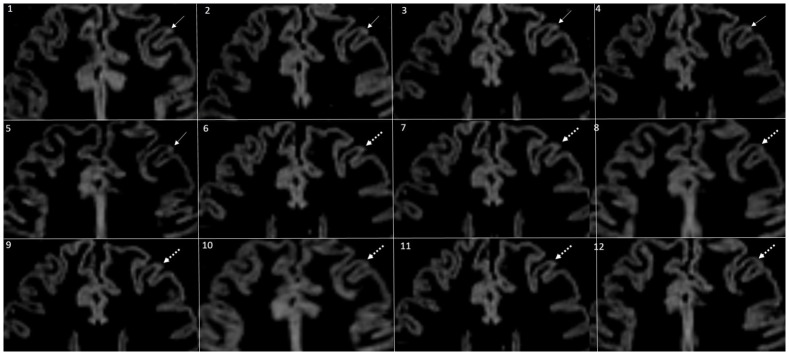
Visibility of a CL over all 12 time-points.Fig 1 depicts a relatively small cortical lesion followed over all 12 time-points. The CL was scored by consensus (conL) in the first 6 TP (white arrow). From TP 7 to TP 12 (dotted white arrows), the specific CL was no longer detected by both of the raters consensually (non-consenus lesion).